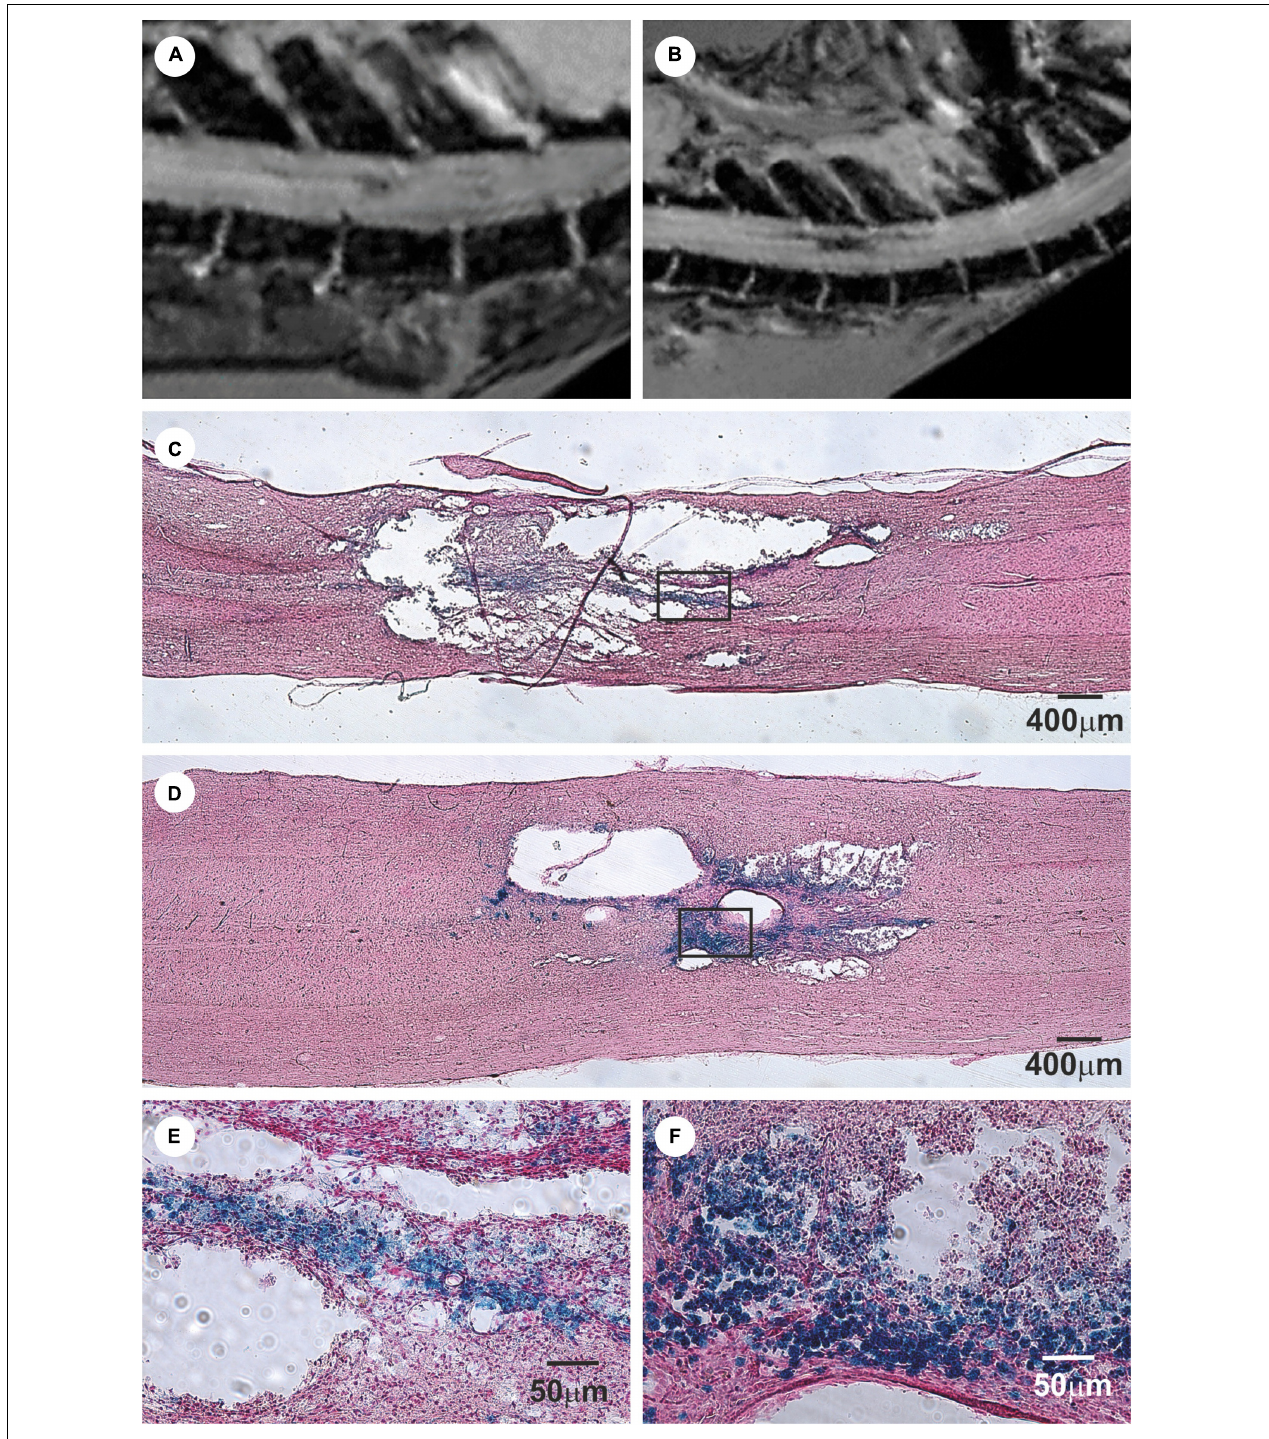
FIGURE 2 | Bone marrow mesenchymal stem cells (BMSCs) labeled with iron-oxide nanoparticles implanted into rat with acute balloon-induced spinal cord compression lesion. (A,B) Longitudinal MRI images of spinal cord lesion. (A) At 5 weeks after compression the lesion was detected as a hyperintensive area with a weak hypointense signal. (B) Entire lesion populated by intravenously injected magnetically labeled BMSCs at 4 weeks after implantation is visible as a dark hypointensive area. (C) Prussian blue staining for iron of a spinal cord lesion in control animal. (D) Prussian blue staining for iron of a spinal cord lesion at 4 weeks after labeled BMSCs implantation. Note the smaller lesion size in the animal with implanted BMSC. (E) Prussian blue staining in detail shows a staining for hemoglobin. (F) The lesion is populated with Prussian blue-positive cells. Modified from Jendelová et al. (2004).